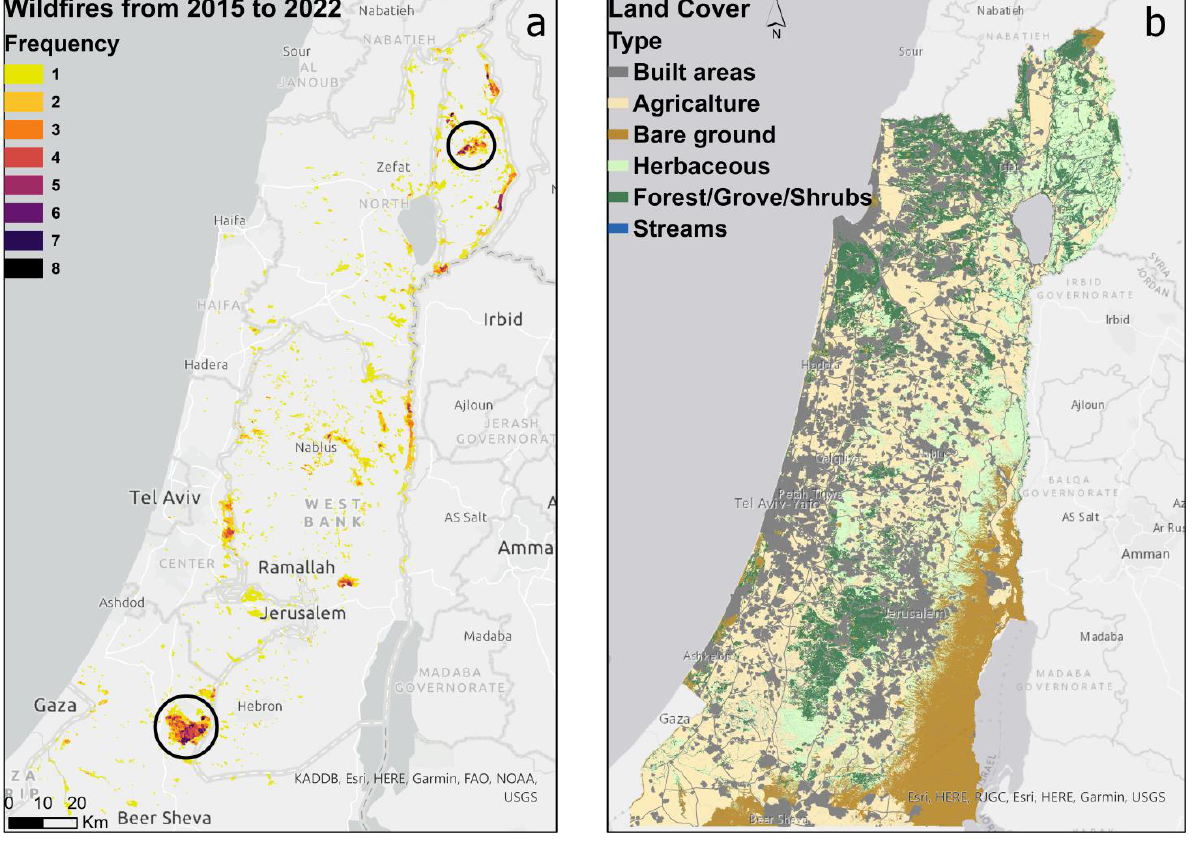
Figure 12. The frequency of wildfires from 2015 to 2022 ( a ) and land cover 2019–2020, INPA ( b ). Circles indicate two examples of military training zones.